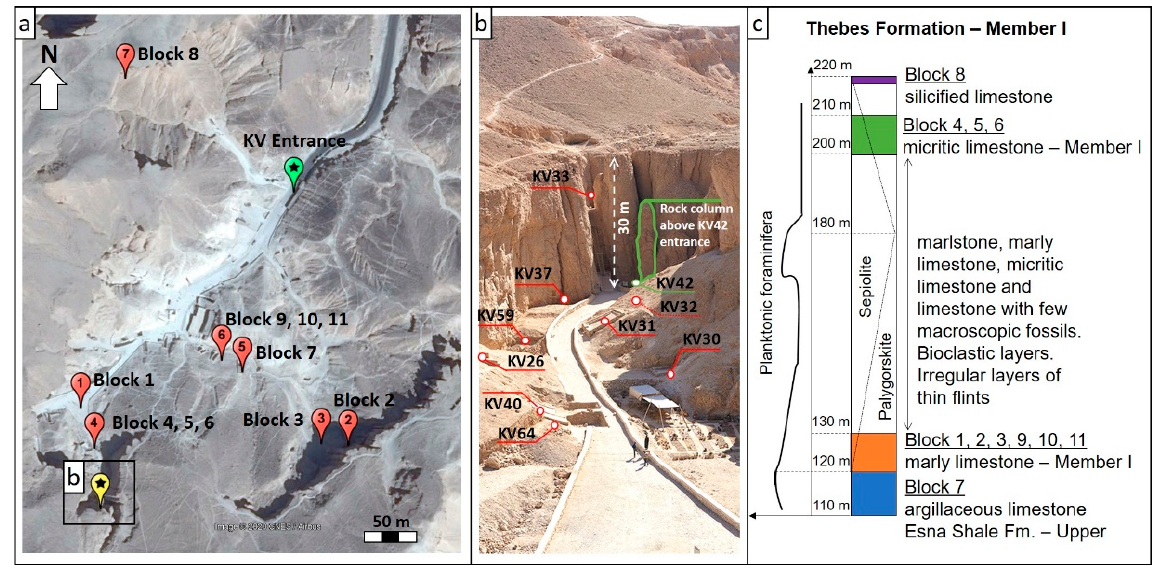
Figure 2. Introduction to the Valley of the Kings and the study area. ( a ) Satellite picture taken from Google Earth Pro [32]; imagery date 11 February 2018, showing the location of origin of the block samples (Block #) marked on the map. ( b ) Photograph of the southern branch of the valley at the University of Basel’s excavation area, with marks (KV#) showing the tomb entrances (picture faces south). Tomb KV42 has a rock column located directly above the tomb’s pit entrance, outlined in green ( c ) Stratigraphic column of Member I—Thebes Formation. The upper region of Esna Shale was added to describe block 7.